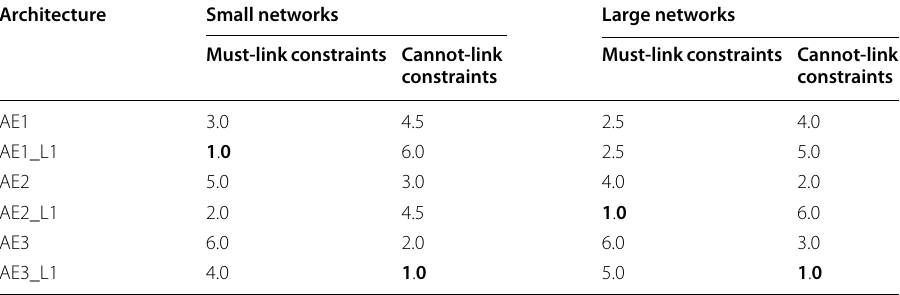
Table 5 Average rank of autoencoder architectures over all small and large LFR networks, for must-link and cannot-link